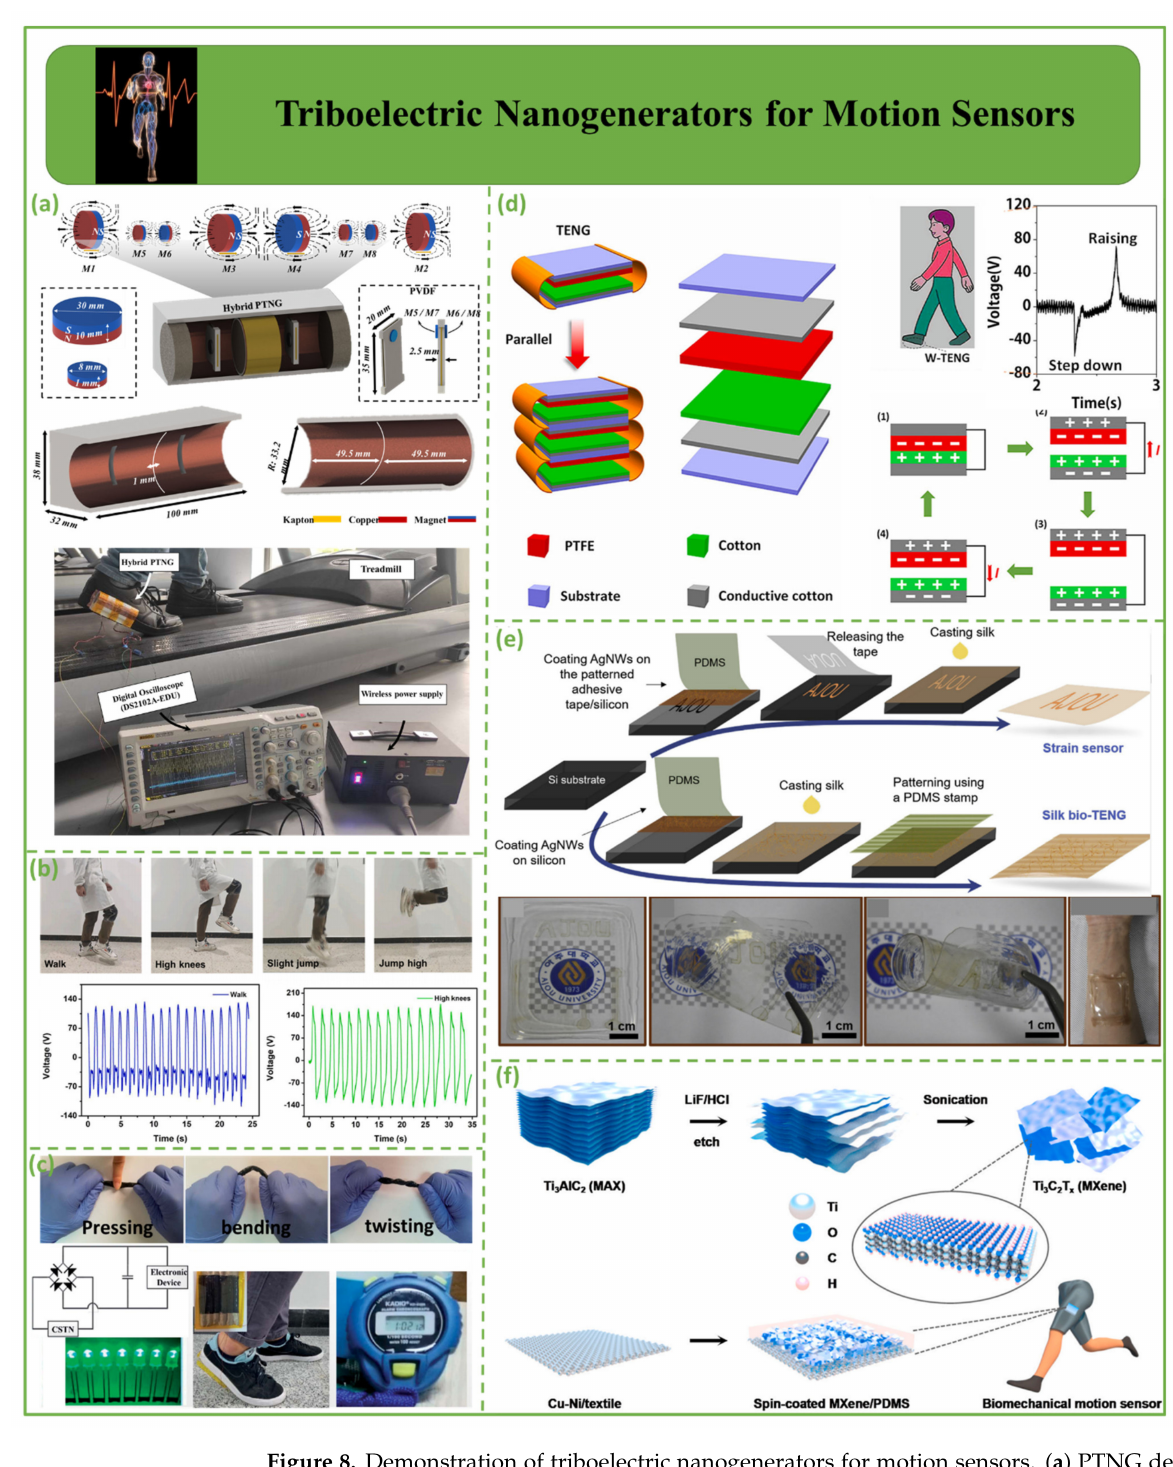
Figure 8. Demonstration of triboelectric nanogenerators for motion sensors. ( a ) PTNG device for energy harvesting and human motion detection [100]. ( b ) SF − TENG monitors various human body motion states [101]. ( c ) A CSTN’s pushing action, bending motion, and twisting motion are demonstrated [102]. ( d ) W − TENG sensor for detection of human walking posture [103]. ( e ) Concept for a silk protein-based strain sensor and triboelectric nanogenerator (TENG) [104]. ( f ) Flexible single-electrode triboelectric nanogenerators for biomechanical motion sensors